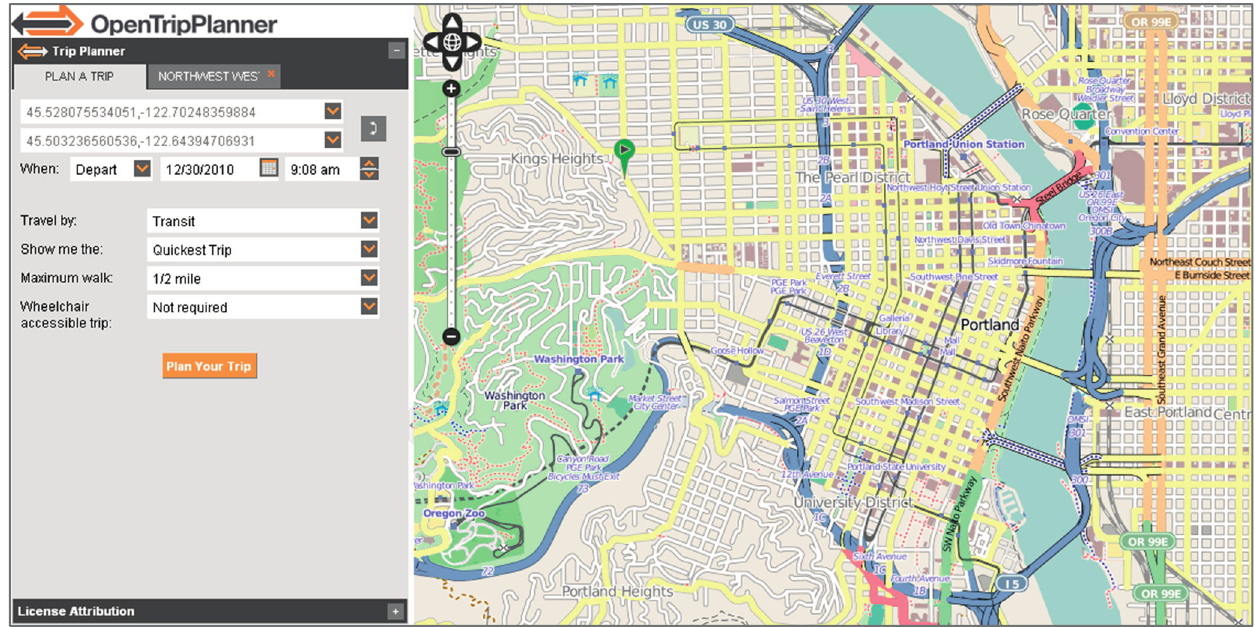
Figure 11. OpenTripPlanner map-based web